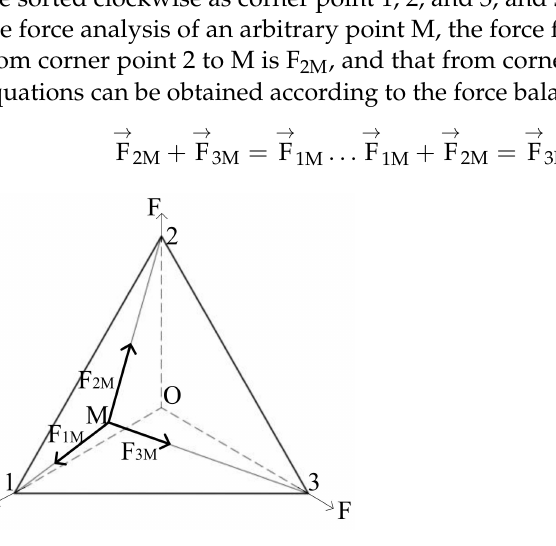
Figure 1. Analysis of the force at any point of the positive triangle.